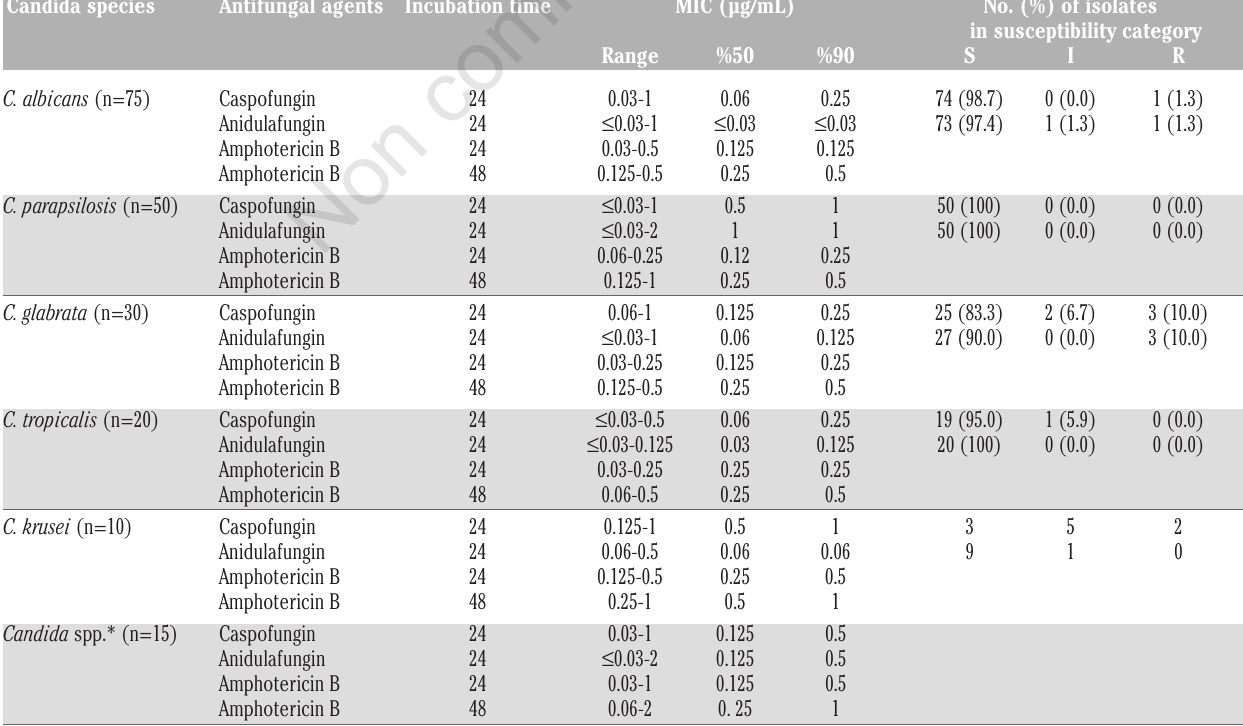
Table 3 Antifungal susceptibility test results by broth microdilution methods. Candida species